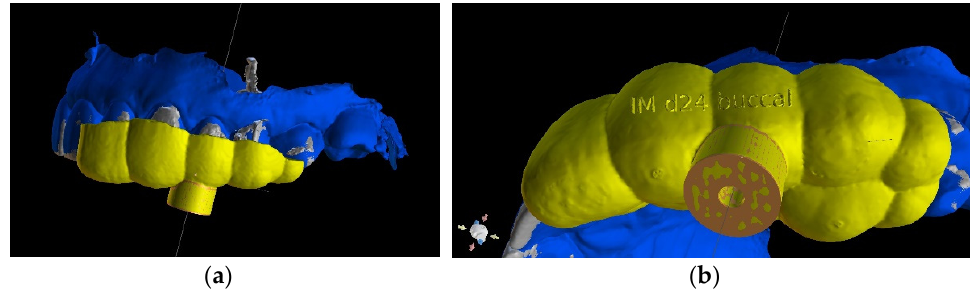
Figure 21. Three-dimensional image of ( a ) endodontic guide range and ( b ) embossed canal marking on the labial template’s surface.